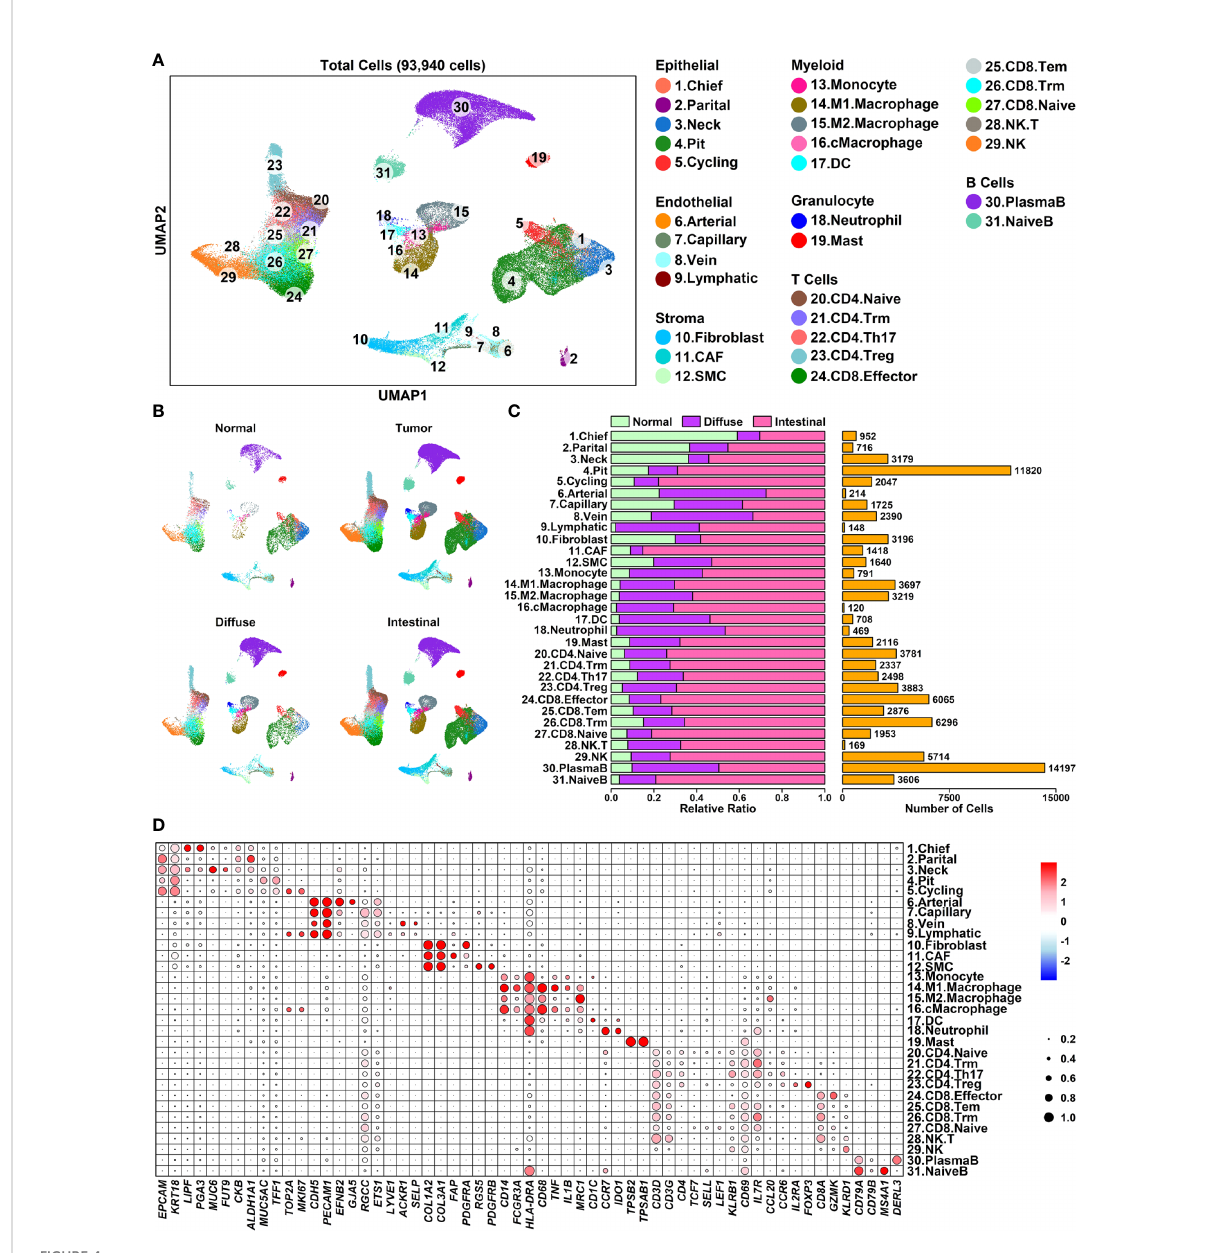
FIGURE 4 A single-cell atlas of human diffuse and intestinal type GC samples (A) UMAP plot showing the distribution patterns of 6 major groups and 25 subgroups; (B) UMAP plots showing the distribution patterns of all groups per sample type; (C) Bar plot showing the basic information of 25 subgroups; (D) Dot plot representing relative expression status of all marker genes used in the determination of each subgroup. Average expression values of each gene within a certain subgroup are represented using color, and the ratios of gene-expressing cells within a certain subgroup are represented using circle